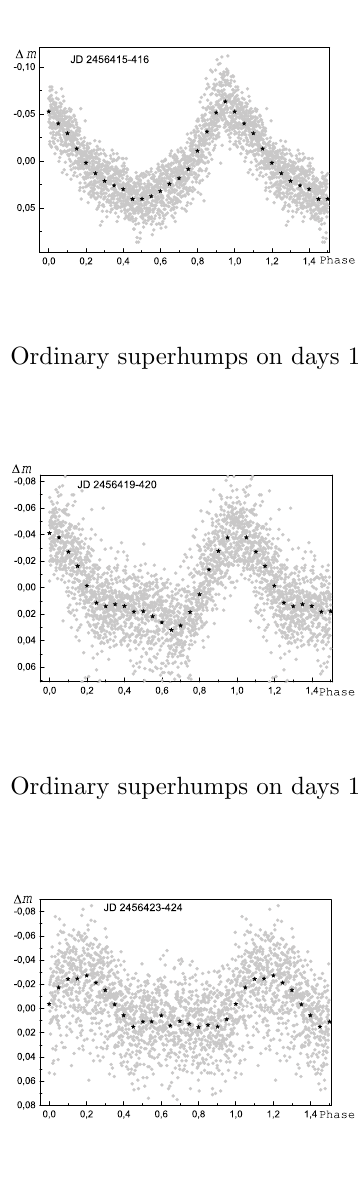
Figure 6: Ordinary superhumps on day 5 AM.